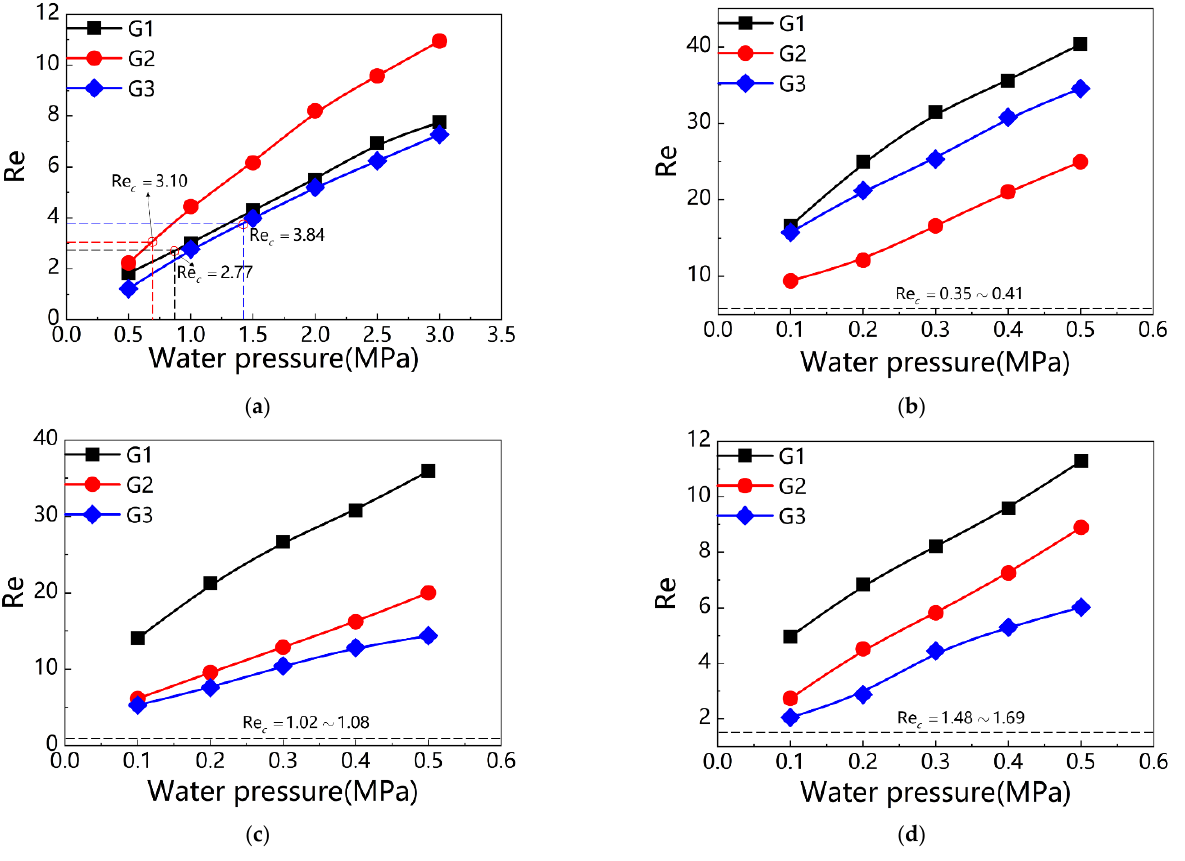
Figure 7. Variation curve of Reynolds number with water pressure: ( a ) unfilled condition, ( b ) filled with 50 mesh quartz sand, ( c ) filled with 100 mesh quartz sand, and ( d ) filled with 200 mesh quartz sand.